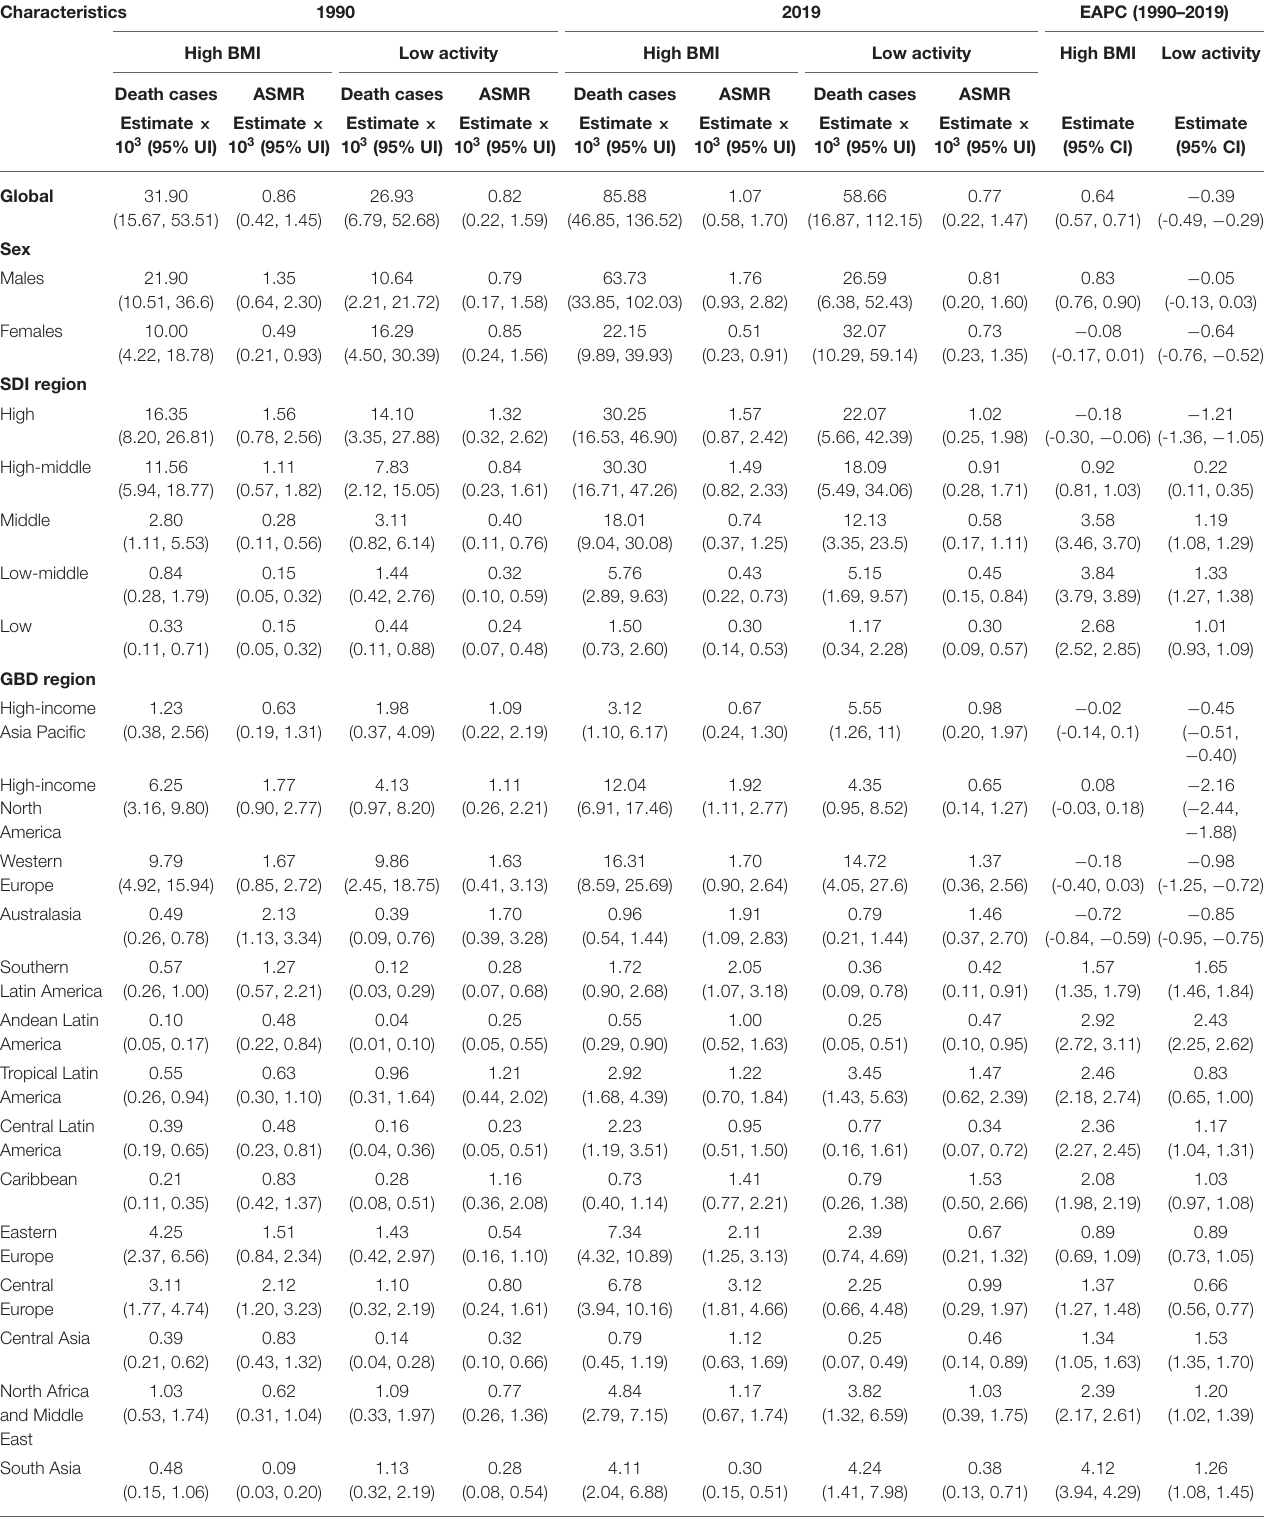
TABLE 1 | Death cases and ASMR of colorectal cancer due to low physical activity and high BMI in 1990 and 2019 and the temporal trends from 1990 to 2019.